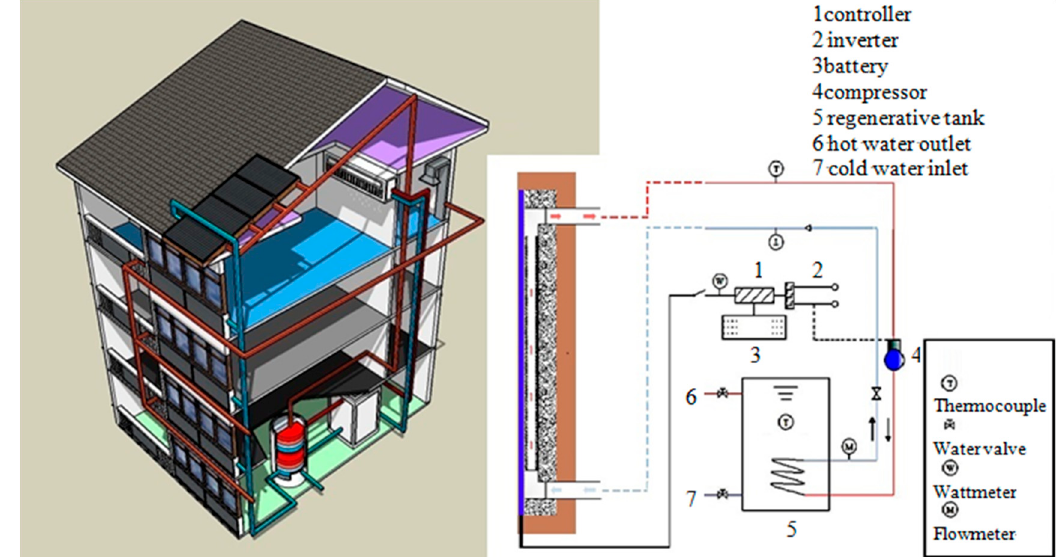
Figure 5. Principle of module-building integration system.